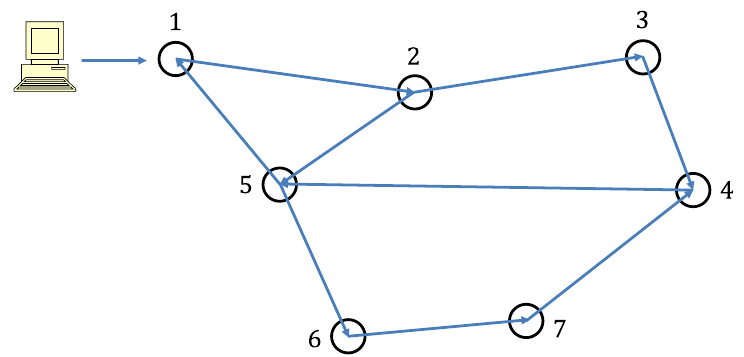
Figure 11. Communication topology of distributed CG.